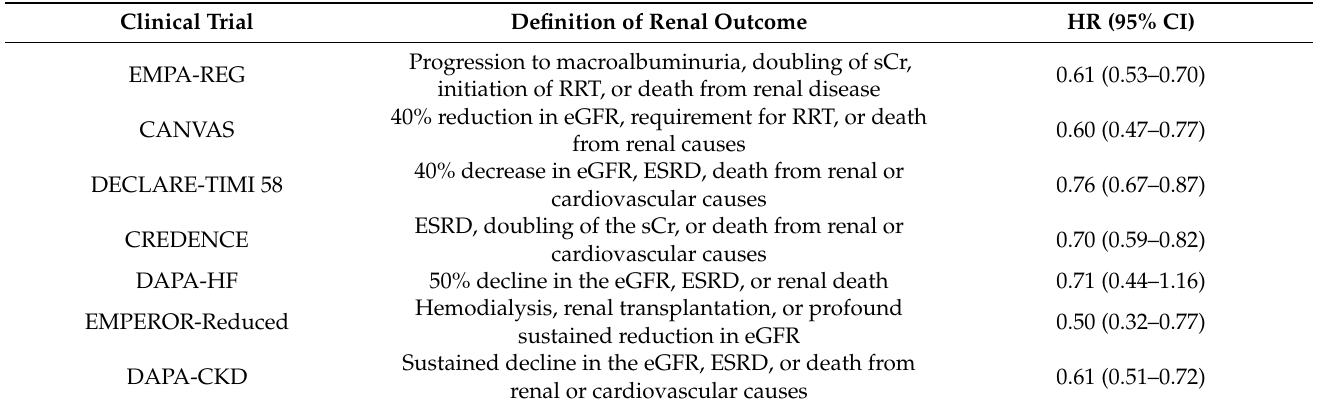
Table 2. Renal outcome in clinical